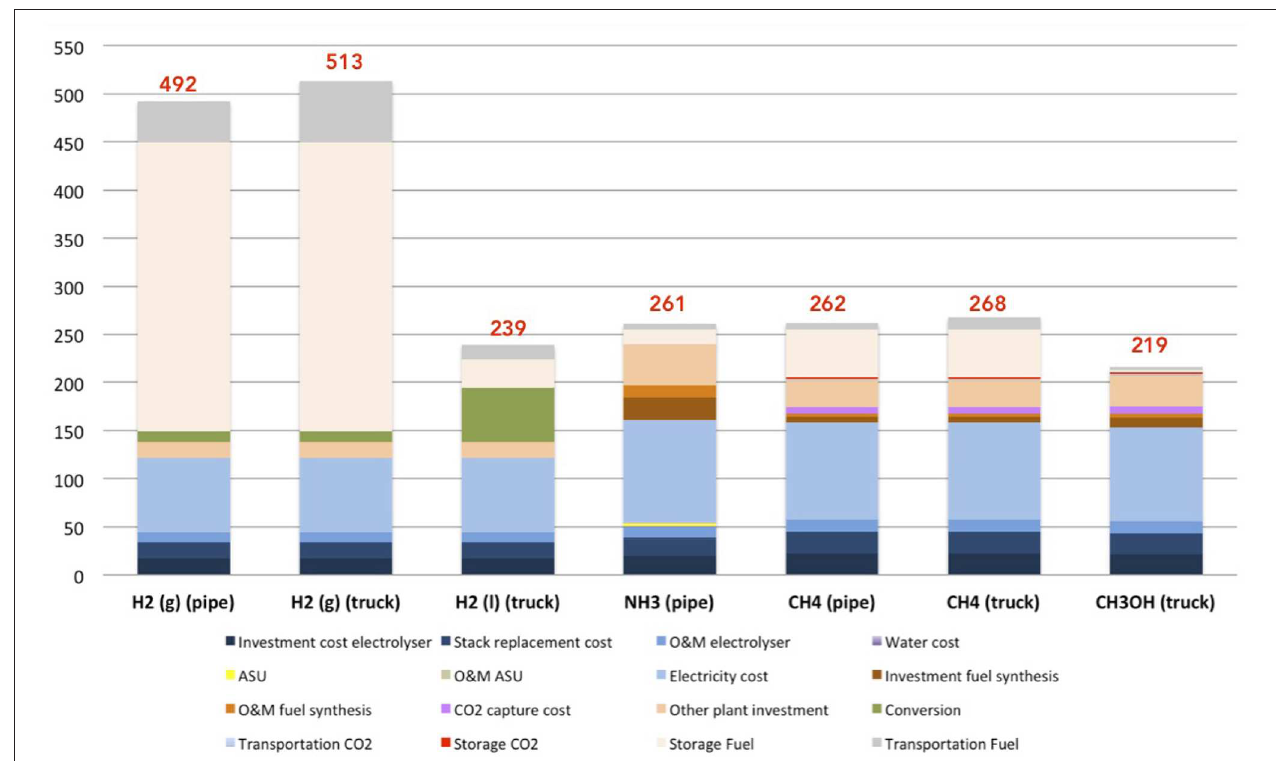
FIGURE 7 | Global costs (production, storage, and transportation) for each fuel in e /MWh fuel , with 30 e /tonCO 2 .